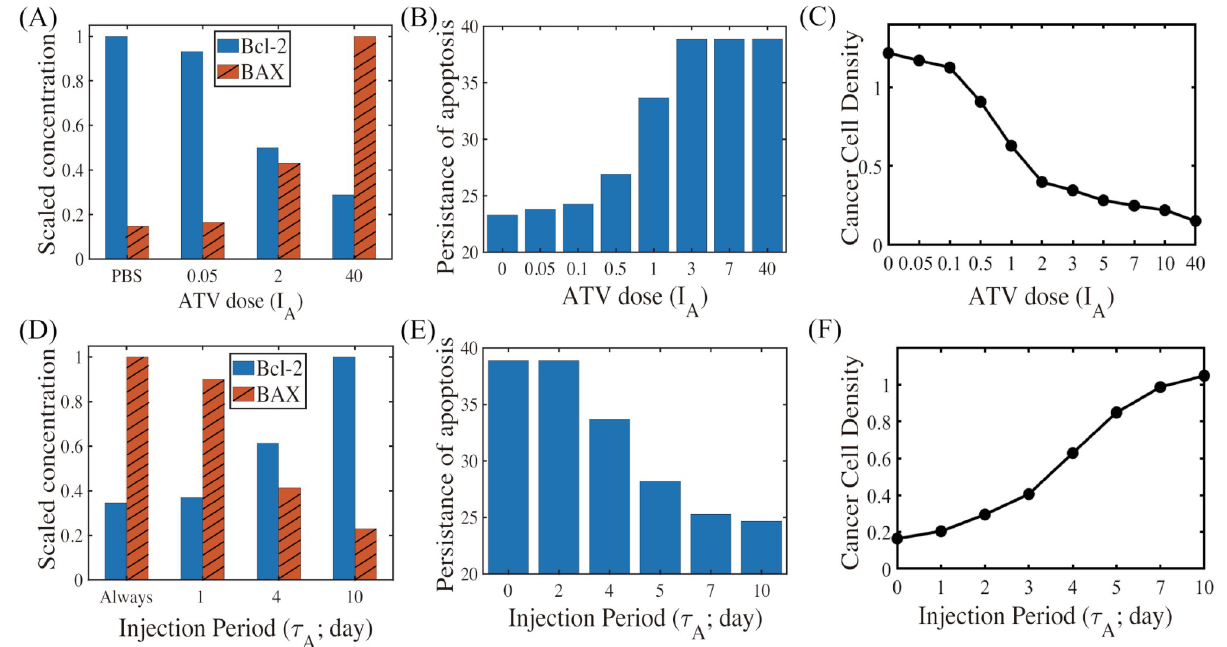
Fig 9. Effect of ATV injection schedule on apoptosis and tumor growth in the combination (TZB+ATV) therapy. (A) Normalized levels of Bcl-2 (blue) and BAX (red) in response to periodic ATV infusion schedule with various doses ( I = 0( PBS ), 0.05, 2, 40). (B) Persisting time of ATV-induced A apoptosis status in response to various ATV doses ( I A = 0, 0.05, 0.1, 0.5, 1, 3, 7, 40). (C) Dose response: cancer cell density in response to various ATV = 0, 0.05, 0.1, 0.5, 1, 2, 3, 5, 7, 10, 40). � τ was fixed in (A-C): τ = 4 days . (D) Normalized levels of Bcl-2 (blue) and BAX (red) in response to doses ( I A A A periodic ATV infusion schedule with various ATV injection periods ( τ A = 0, 1, 4, 10 days ). (E) Persisting time of ATV-induced apoptosis status in response to various ATV injection periods ( τ A = 0, 2, 4, 5, 7, 10 days ). (F) Dose response: cancer cell density in response to various ATV injection periods ( τ = 0, 1, 2, 3, 4, 5, 7, 10). � ATV dose ( I ) was fixed in (D-F): I = 2. A A A